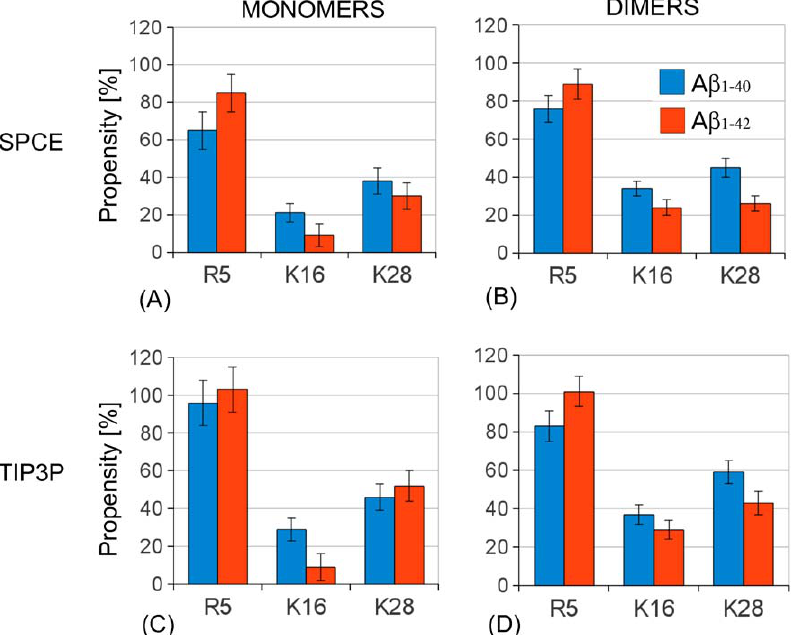
Figure 8. Histograms of salt bridge propensities. Total salt bridge propensities of the three positively charged amino acids: R5, K16, and K28 in A b 1 { 40 and A b 1 { 42 monomers and dimers are displayed as histograms for each of the two water models.